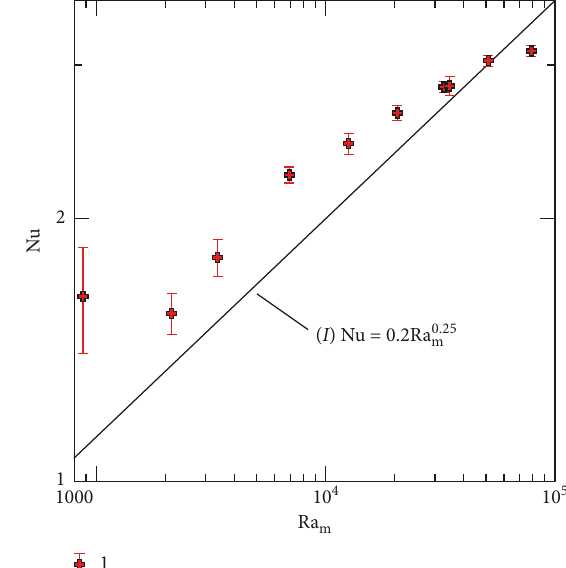
Figure 4: The dependence of Nu on Ra in the absence of vi- m brations. Curve I is plotted according to equation (10).